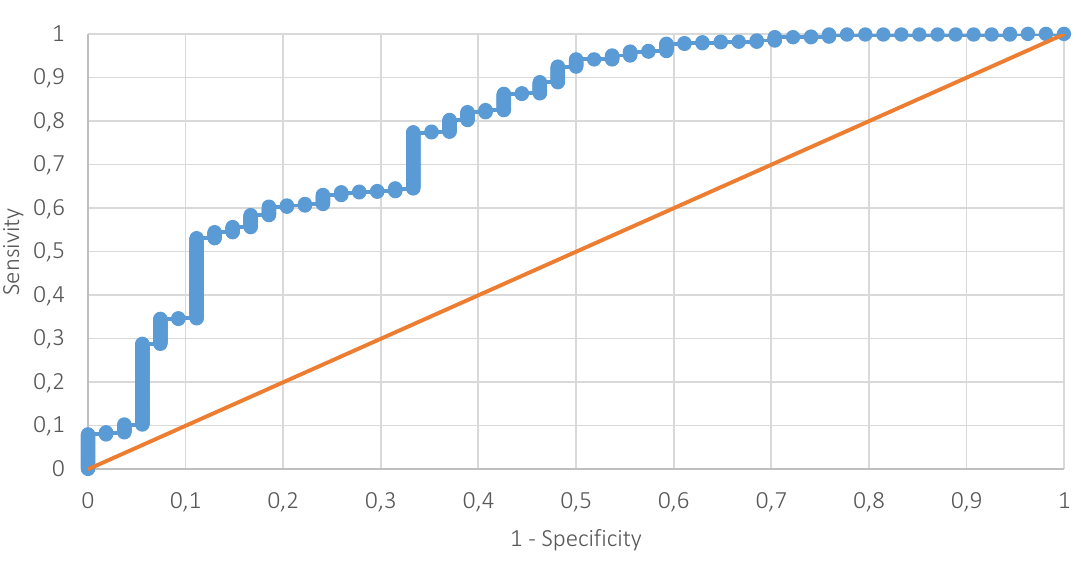
Figure 1. Discriminatory power RL ( ROC